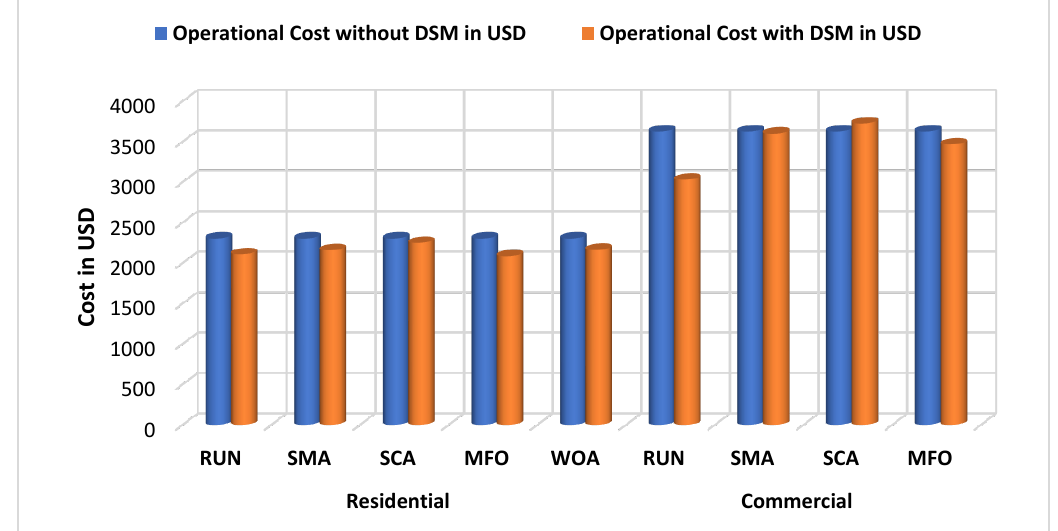
Figure 13. Operational cost reduction by load shifting.